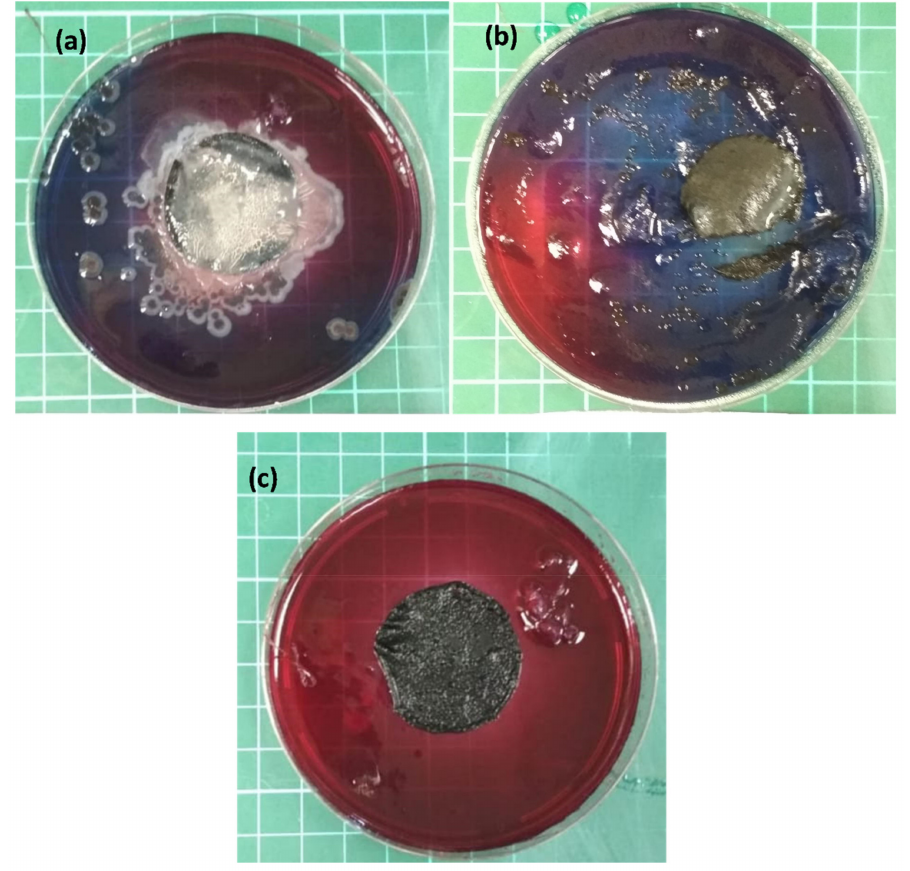
Figure 5. Antimicrobial activity test, using the colony counting technique for the ( a ) reference CNT, ( b ) PANI / CNT physical mixture, and ( c ) the PANI-coated CNT membranes. Red indicated no bacteria populations at all, whereas blue indicated intense bacterial activity.